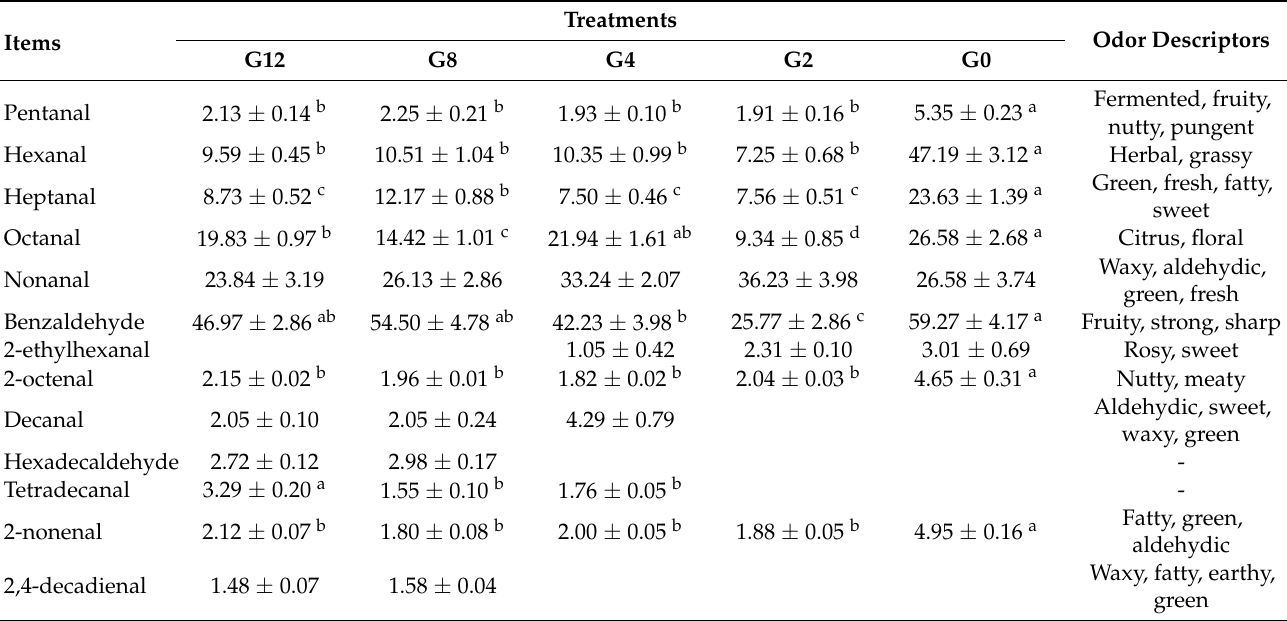
Different superscripts (a, b, c and d) indicate significant differences ( p < 0.05). The values are the means ± SE ( n = 10 per group). G12, G8, G4, and G2 mean that the lamb grazing time was 12 h, 8 h, 4 h, and 2 h per day, respectively. G0 means indoor supplementary